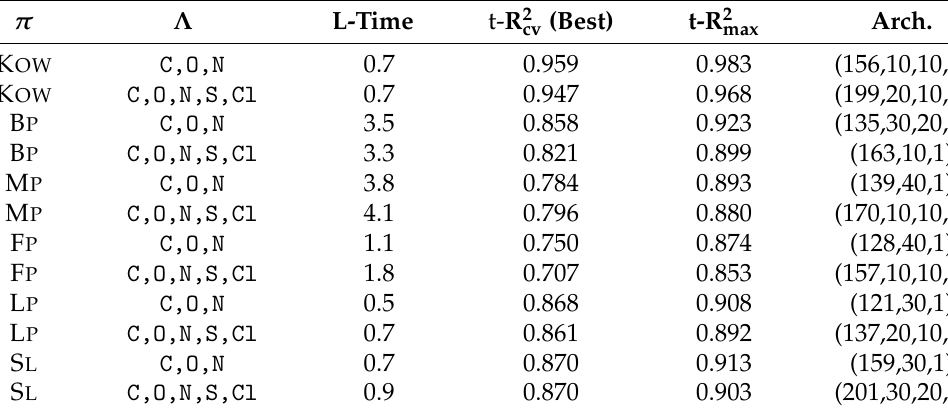
Table 4. Results of Stages 2 and 3 in Phase 1.